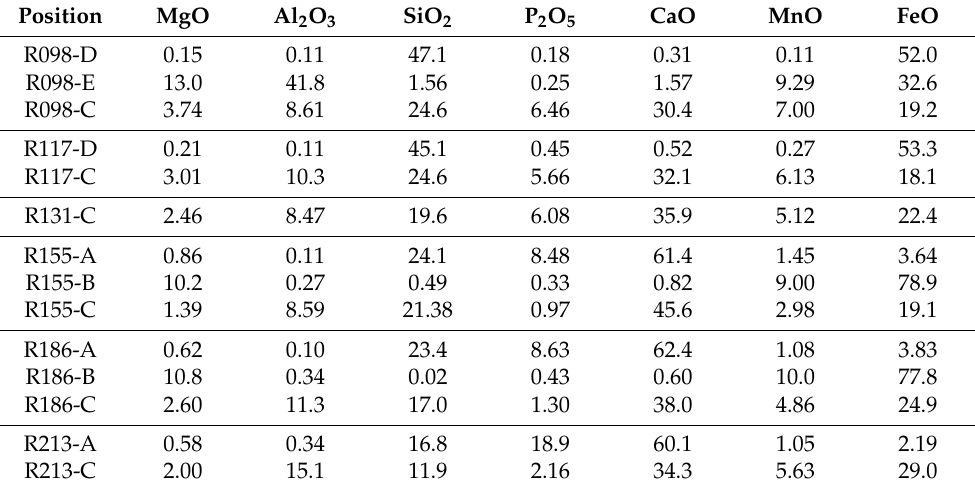
Figure 6. SEM images of the dephosphorization slag with magnification of 1000 times at different basicities. Table 4. Compositions of each phase determined by EDS for dephosphorization slags with different basicities (mass%).